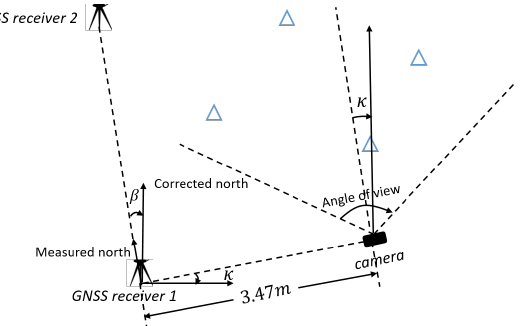
Figure 15. Design of experiment setup. GNSS receiver 1 occupies the origin of the world frame, its North can be related to the ECEF frame by measuring the relative position between the two GNSS receivers. Once the measurements of the two high-end GNSS receiver are completed, GNSS receiver 2 was moved to the camera position, and GNSS receiver 1 was swapped with the total station. The camera is set up locally horizontal and aligned with the world frame surveyed with the total station, about 3.5 m away. Heading κ is obtained by the total station, so that a full ground truth is available for the camera state. The landmarks (blue) are placed within the angle of view and a maximum range of 8 m. The true camera pose was: κ = 3.48 rads, X 0 = − 3.192 m, Y 0 = − 1.360 m, Z 0 = 1.408 m (used